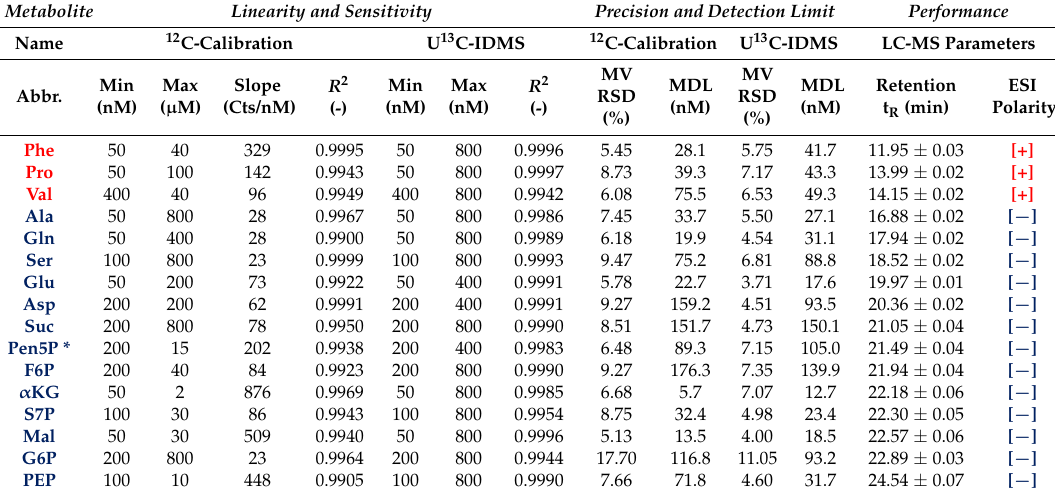
Table 2. Quantification parameters of targeted metabolites by standard-based external 12 C and IDMS U 13 C calibration using QTOF-HRMS detection after EDR tune in positive (red) and negative (blue) ionization mode (5 µ L sample injection). See Tables S1–S4 for the full names of abbreviated metabolites.